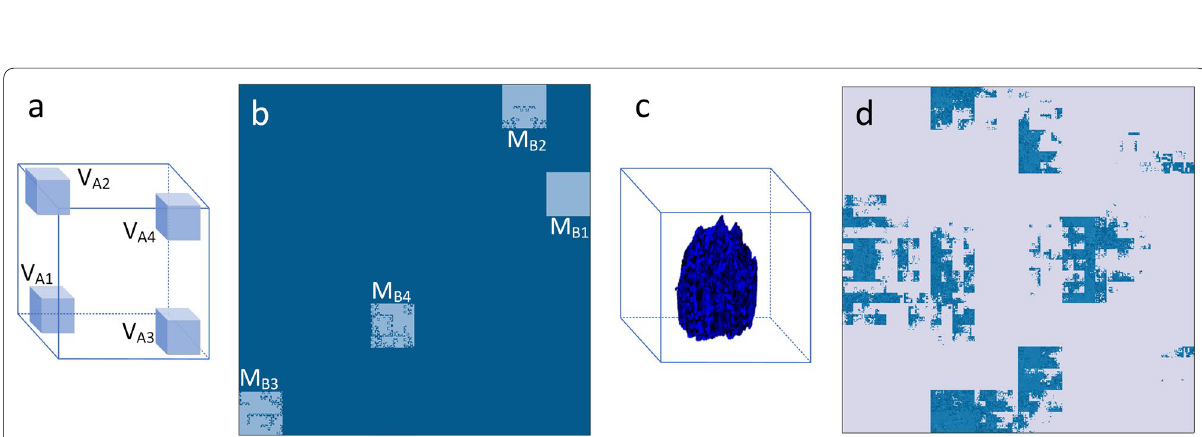
Fig. 6 a A Hilbert volume consisting of four blocks of V A1 , V A2 , V A3 , and V A4 was expanded into a Hilbert matrix ( b ). The corresponding expansions of the four blocks were M B1 , M B2 , M B3 , and M B4 on the matrix, respectively. c The Hilbert volume with the lung tumor inside was expanded to a two-dimensional Hilbert matrix ( d ). Accordingly, the voxels of the lung tumor ( c ) in blue were expanded into the pixels of the matrix ( d ) in